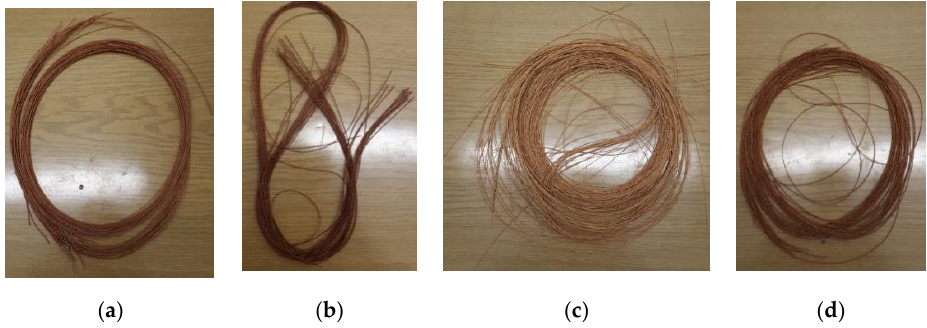
Figure 2. Photos of samples of four materials submitted for testing: ( a ) I — Kordarna Plus PA6; ( b ) II — PA6_Cordenka; ( c ) III — PES 1440; and ( d ) IV — Kordarna Plus PES. The names, symbols and material parameters declared by the manufacturer of the tested cords were presented in Table 1. Table 1. Names and symbols of cord materials used in the tests (manufacturers’ data).